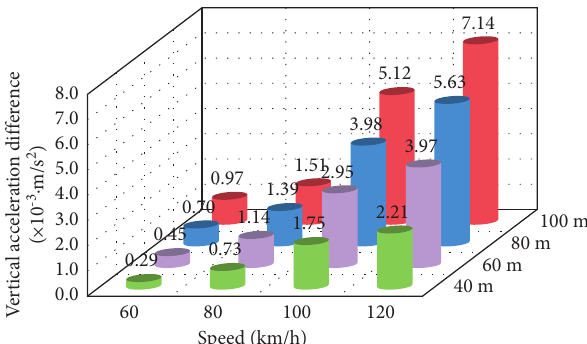
Figure 21: The variation trend of the vertical vibration acceleration